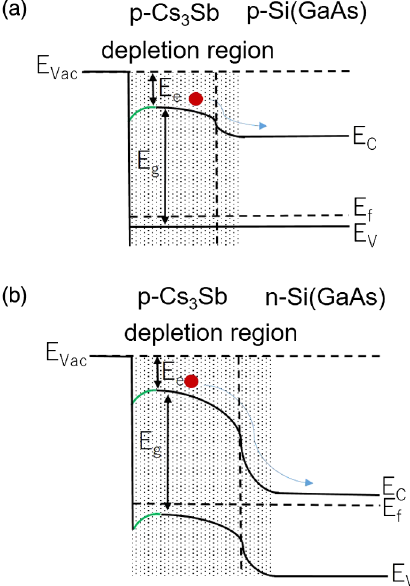
FIG. 5. The energy-band models for semiconductor-semicon- ductor junction between Cs 3 Sb and substrates, (a) p -Si(GaAs), (b) n -Si(GaAs). E is the vacuum level, E is the conduction Vac C band, E is the valence band, E is the electron affinity, E is the V e g bandgap and E is the fermi level. The vertical dashed line f indicates the position of the substrate-cathode interface, and the area of the stripes shows the depletion region. FIG. 4. The energy-band models for semiconductor(metal)- semiconductor junction between CsK 2 Sb and substrates, (a) p -Si (GaAs), (b) n -Si(GaAs), (c) Mo. E is the vacuum level, E is Vac C the conduction band, E is the valence band, E is the electron V e affinity, E is the bandgap and E is the fermi level. The vertical g f dashed line indicates the position of the substrate-cathode inter- face, and the area of the stripes shows the depletion